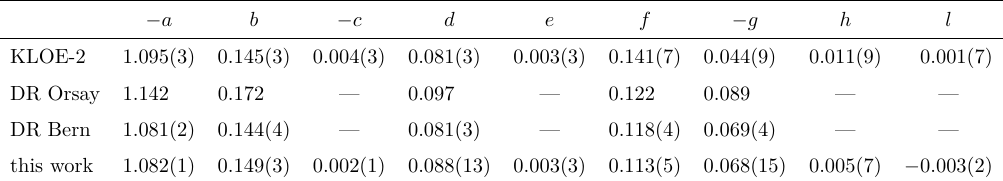
Table 3 . Comparison of the Dalitz-plot parameters obtained in different analyses of the KLOE-2 data [25]. The values given in the first row are obtained by a direct fit of eq. (2.42) to data. The dispersive analyses from the Orsay [46] and Bern groups [47] consider the C -conserving amplitude M C 1